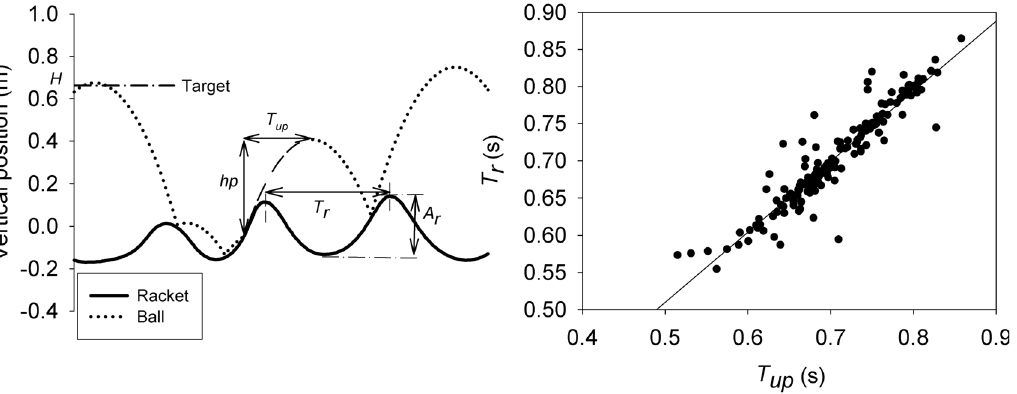
Figure 1. Methods. Left. Definition of variables for racket motion (solid line) and ball trajectory (dotted line). T r and A r refer to racket period and amplitude of racket cycle, respectively. T up and h p refer to the ball upswing duration and the ball peak height, respectively; Right. Illustration of linear regression between T r and T up allowing to determine a coefficient of correlation R c between both variables.